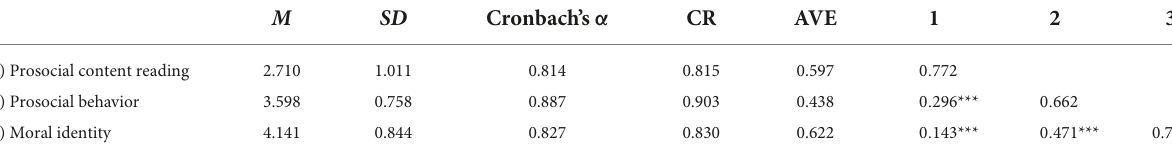
FIGURE1 Hypothesized model.